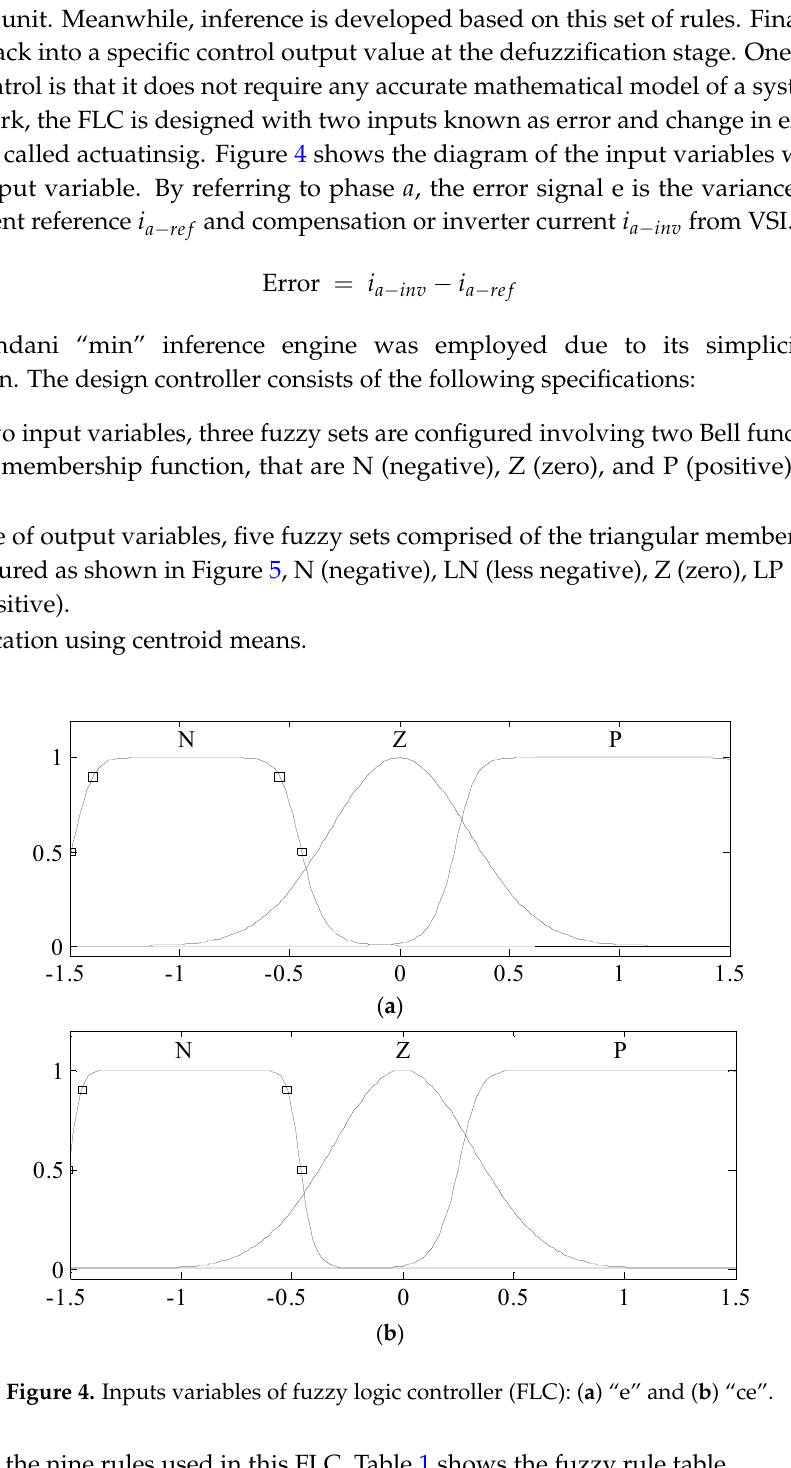
Figure 5. Output variable “actuatinsig” of FLC.